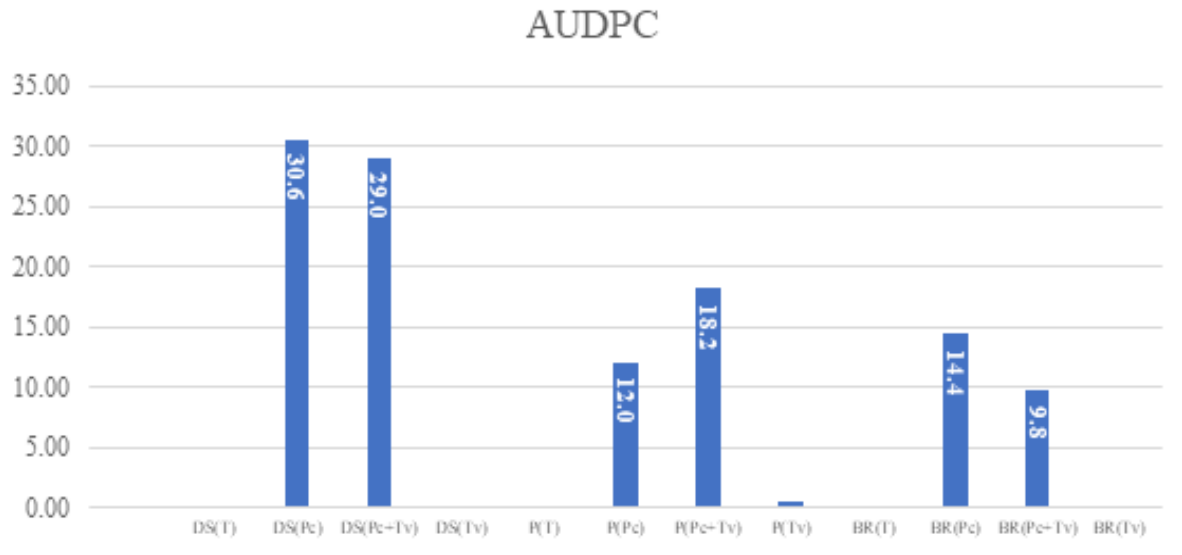
Figure 5. Area averages under the disease progress curve (AUDPC) for the nine evaluations according to treatment in the efficiency test of T. viride as a bio controller for P. capsici under three sowing methods in the pepper crop ( Capsicum annuum